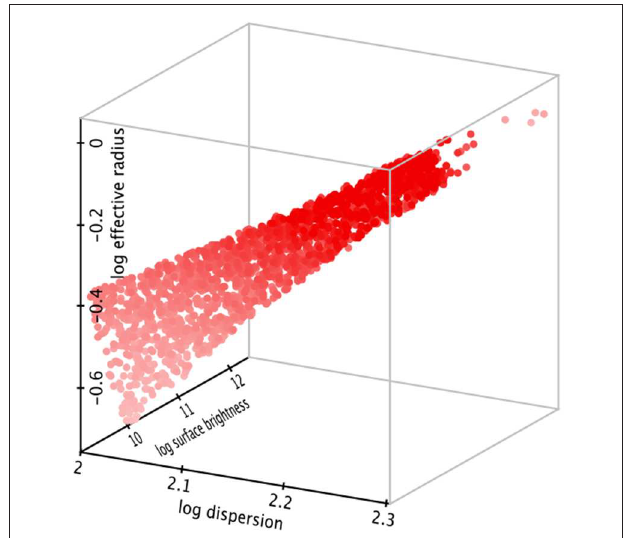
FIGURE 1 | A simulated FP obtained by integrating Equation